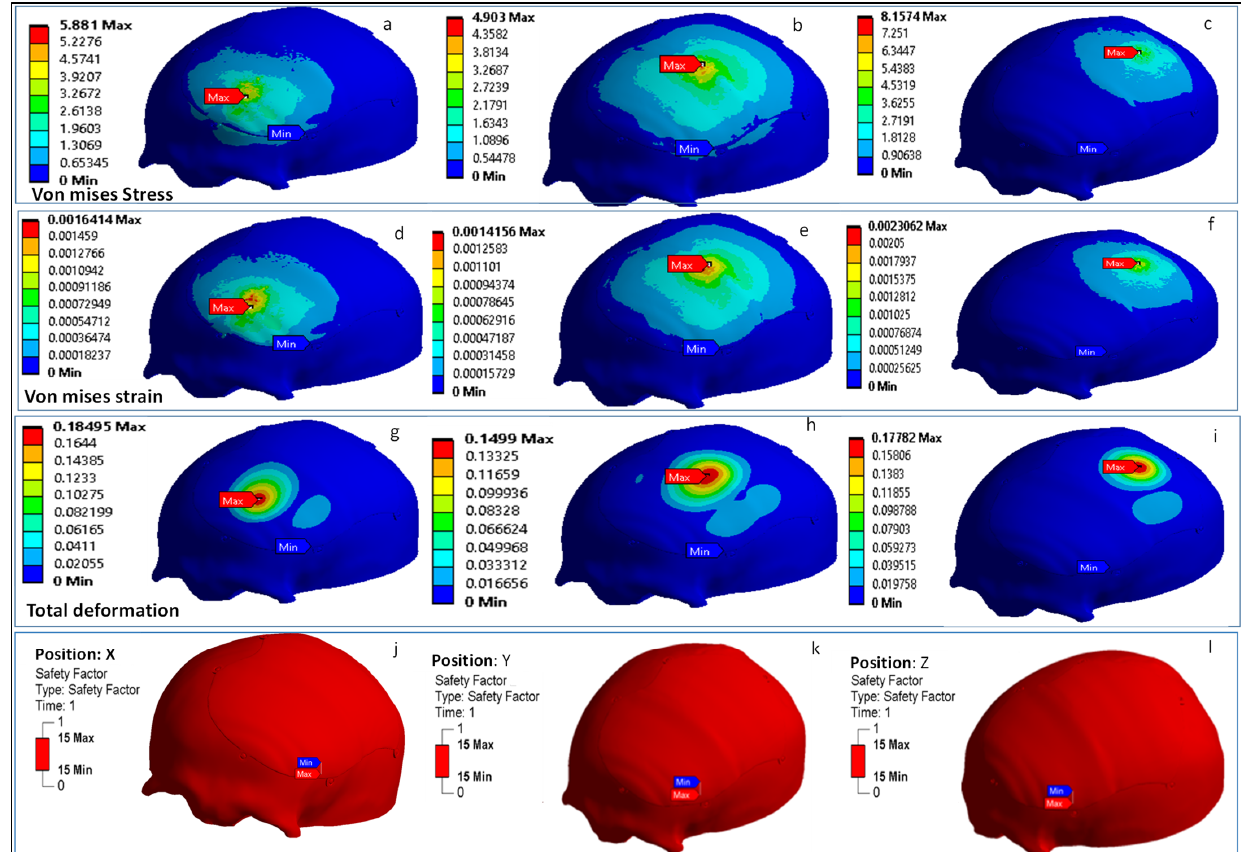
Figure 12. FEA results illustrating: ( a – c ) Von Mises stress at the point, ( d – f ) Von mises strain, ( g – i ) total deformation, and ( j – l ) the factor of safety at points X, Y and Z.